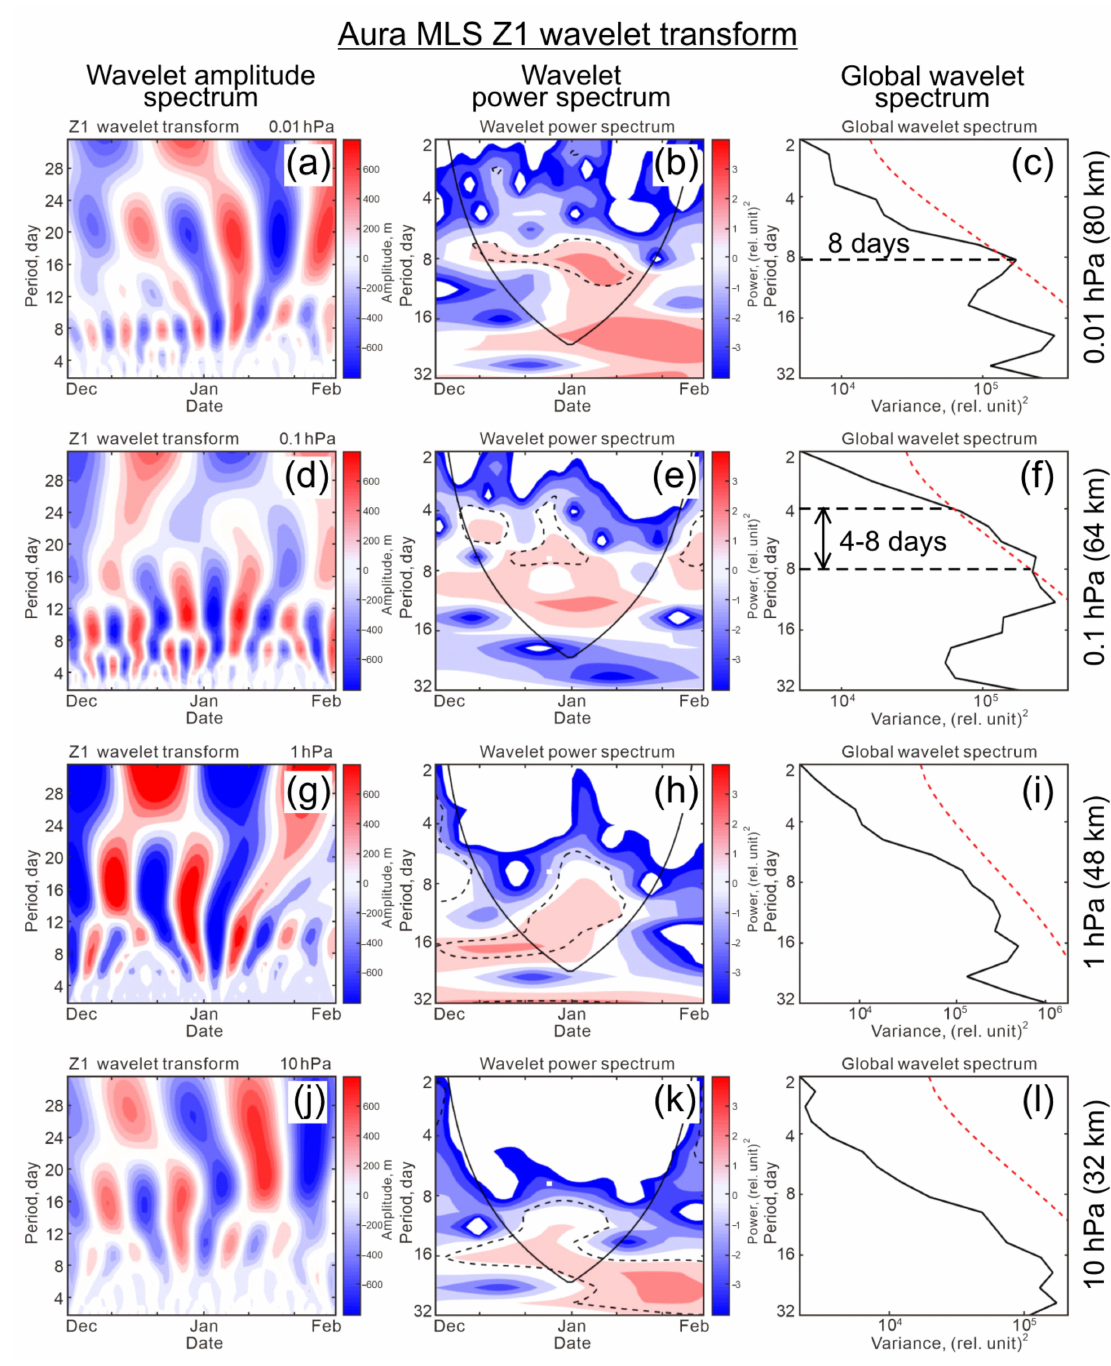
Figure 9. Wavelet transforms of time series of wave-1 amplitude, Z1, for ( a–c ) 0.01, ( d–f ) 0.1, ( g–i ) 1, and ( j–l ) 10 hPa. (left) Wavelet amplitude periods, (middle) wavelet power spectrum, and (right) global wavelet spectrum. Dashed contour in power spectrum and dashed line in global wavelet spectrum indicate 95% confidence level. Note that the vertical scale in the left column is the reverse of the scales in the other two